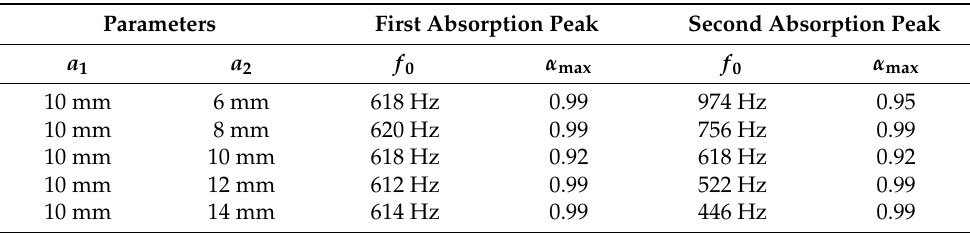
Figure 7. The influence of the size of the cavity to sound absorption performance of the double resonators in simulation. Table 4. The summary of the peak sound absorption coefficient α max and resonance frequency f 0 for double resonators with different size of the cavity.